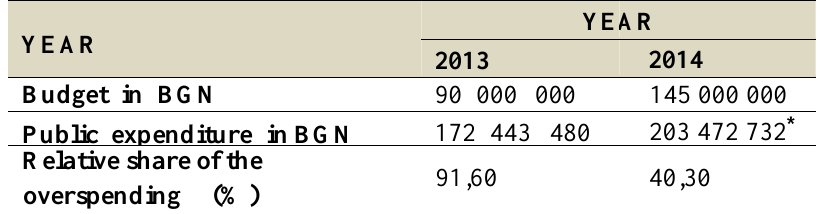
Table 2. Expenses of the medical therapy for oncological diseases, paid outside the costs of clinical pathways (Source: Report on the implementation of the budget of